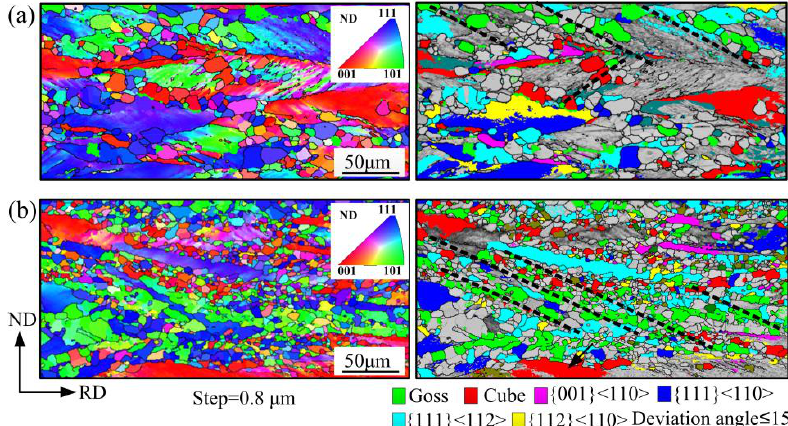
Figure 11. Inverse pole figure map (IPF) and relevant orientation image maps (OIM) of several main components in ( a ) partially recrystallized TCR10 sample and ( b ) partially recrystallized TCR11 sample.